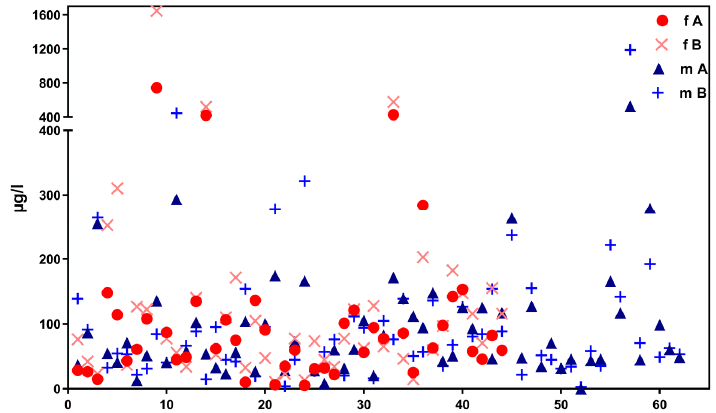
Figure 4. Variability in urinary-concentrations of ∑ 5OH-MEHP + 5oxo-MEHP (A) and 5cx-MEPP (B) concentrations in morning urine of two female (f) and two male (m) subjects aged 40 years or older (general population) over four periods of seven days each (one per season of the year). The number starting with “P” is the subject identifier.